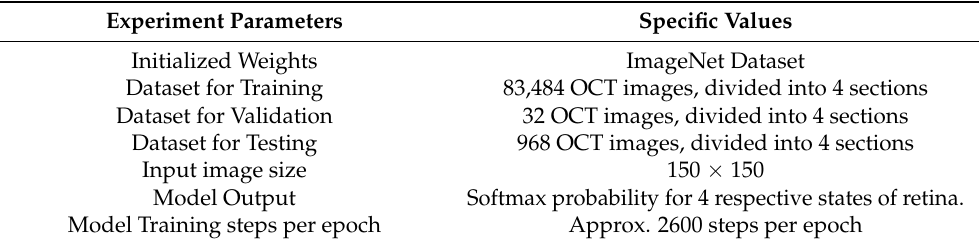
Table 1. Parameters and Data subsets used in proposed work.